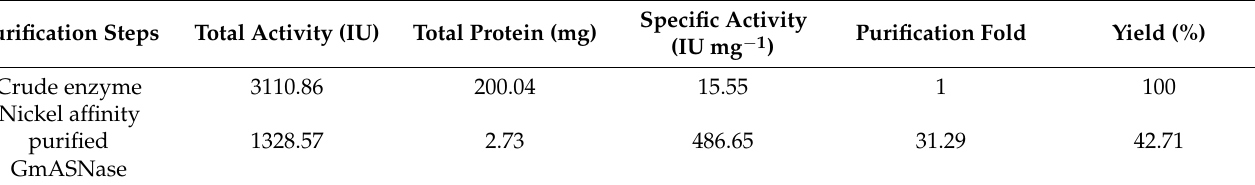
Table 1. Separation and purification of